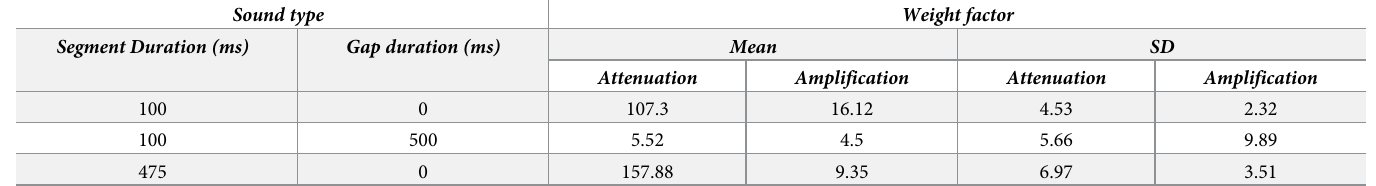
Table 6. Experiment 3. Geometric means and standard deviations of the weight factors for the three different sound types separately for the two different directions of level